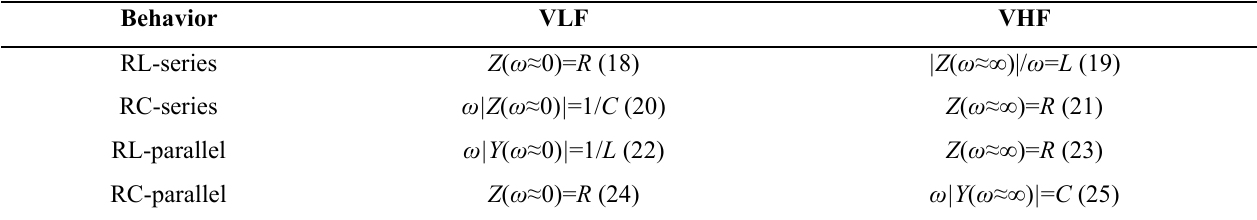
Table 2: First order impedance extreme frequency